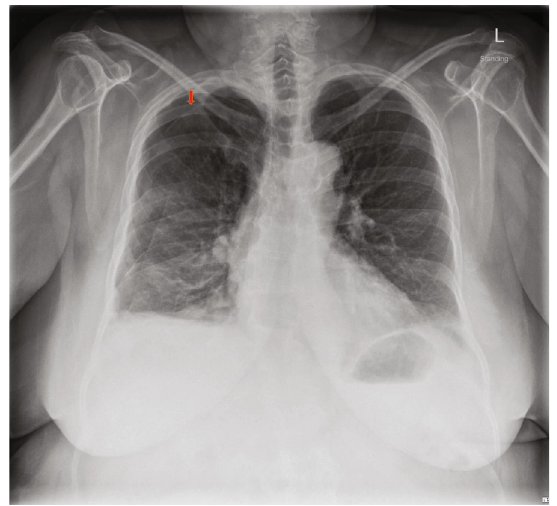
Figure 3: Chest X-ray showing large left-sided pneumothorax and lung collapse (depicted by red arrow).